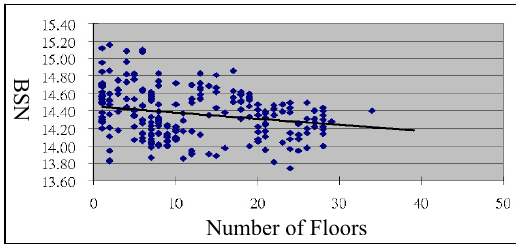
Figure 7. Relationship between NSB and building height (number of floors) in district scale (R 2 = 0.16)